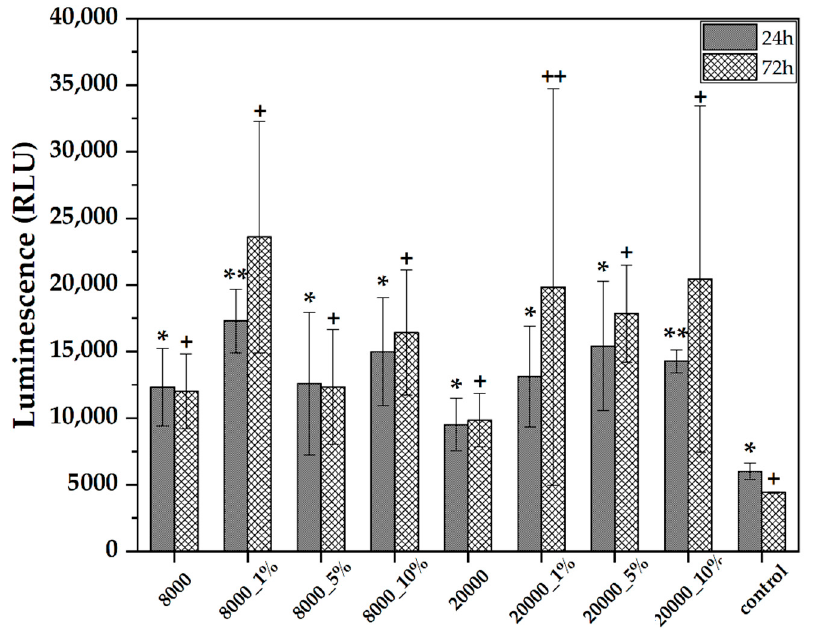
Figure 8. Oxidative stress results for the pristine and the RA-loaded magnetite microspheres (BHK cell line; values are expressed as mean ± standard deviation; different signs indicate significant differences between each sample, * and +—lower significance, ** and ++—higher significance).